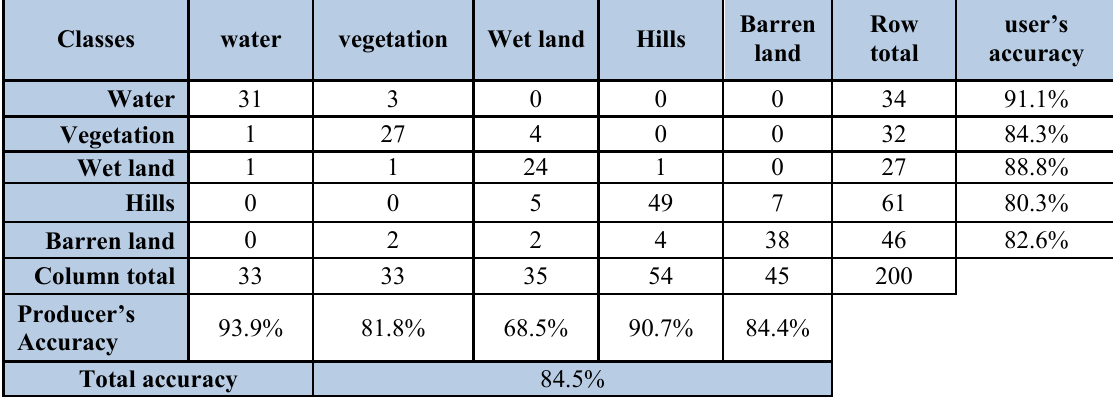
Table 9: Error matrix with producers, users, and overall accuracy calculations for supervised classification using SVD for Landsat-7